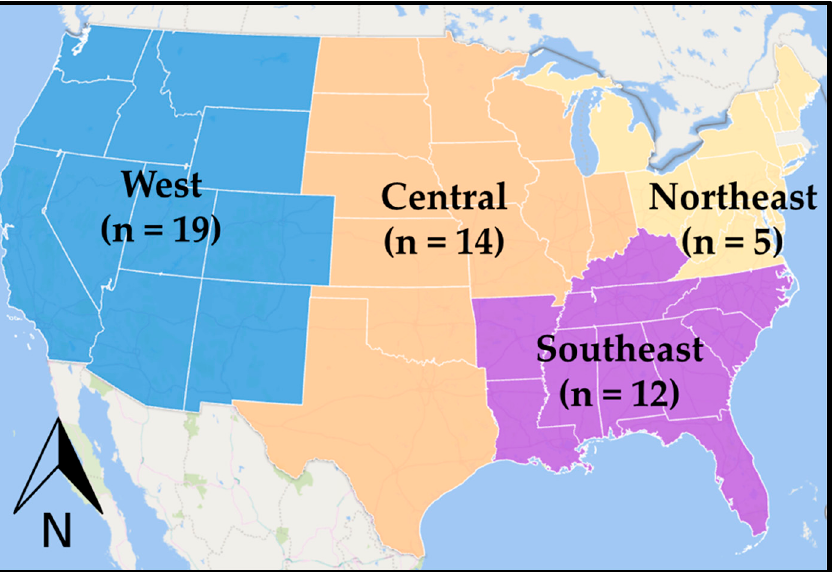
Figure 1. USDA NRCS regional management map and participant sample size in the United States as stratified in this survey.